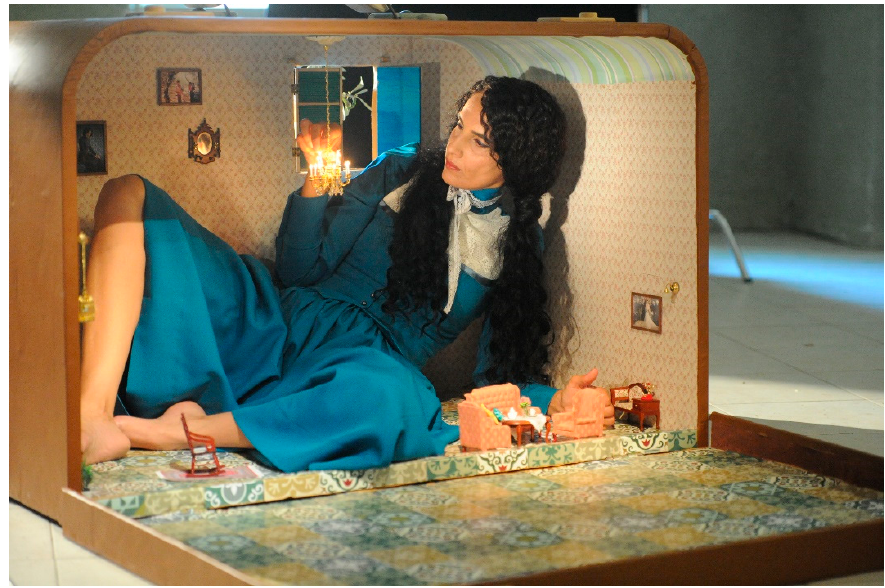
Figure 4. Raida Adon, Strangeness , 2018, Video, 33:30 mins. © Tami Weiss.